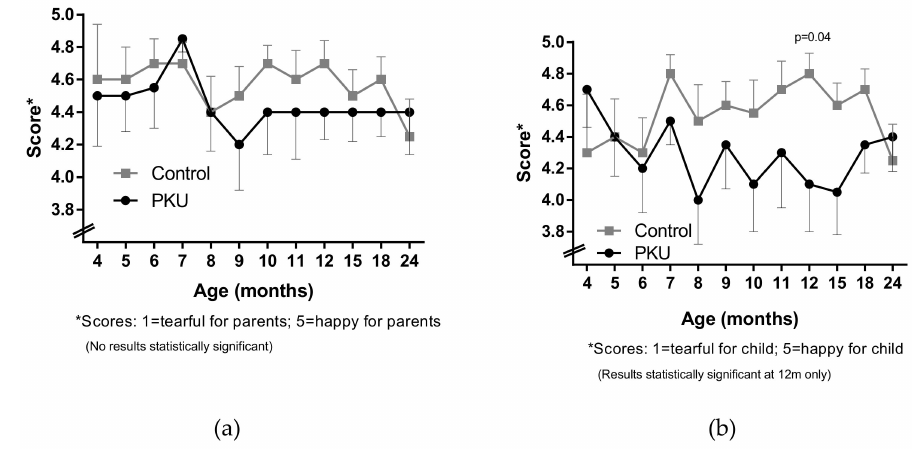
Figure 1. Mean ( a ) maternal and ( b ) child mood during children’s